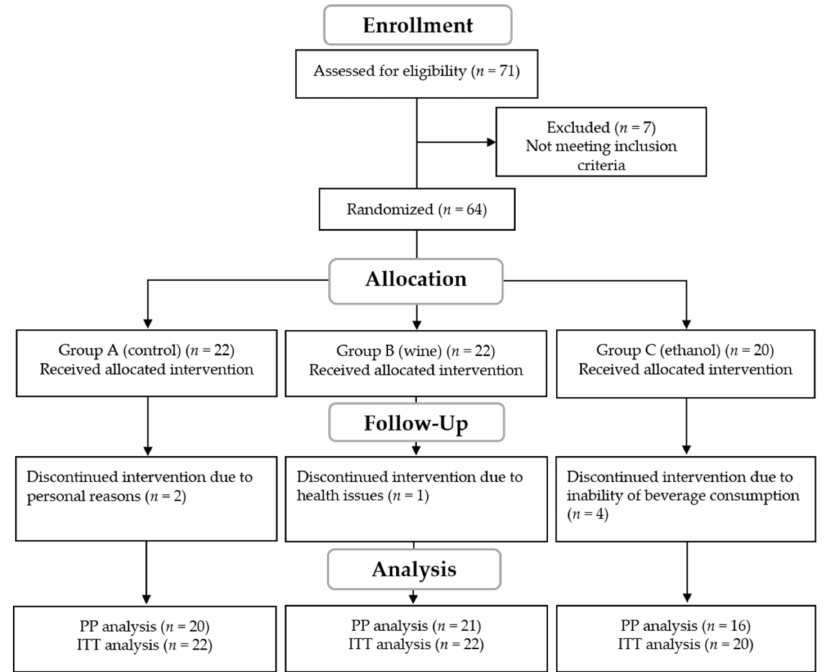
Figure 1. Flowchart of the intervention. PP; per protocol, ITT; intend to